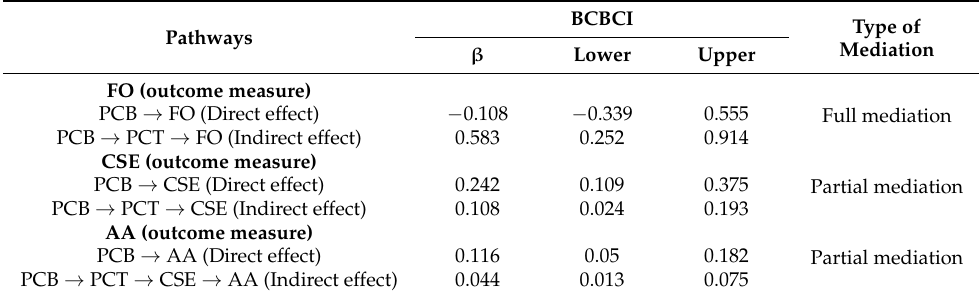
Table 3. Mediation analysis of perceived crime benefit as predictor of future offending, criminal self-efficacy, and arrest avoidance via proactive criminal